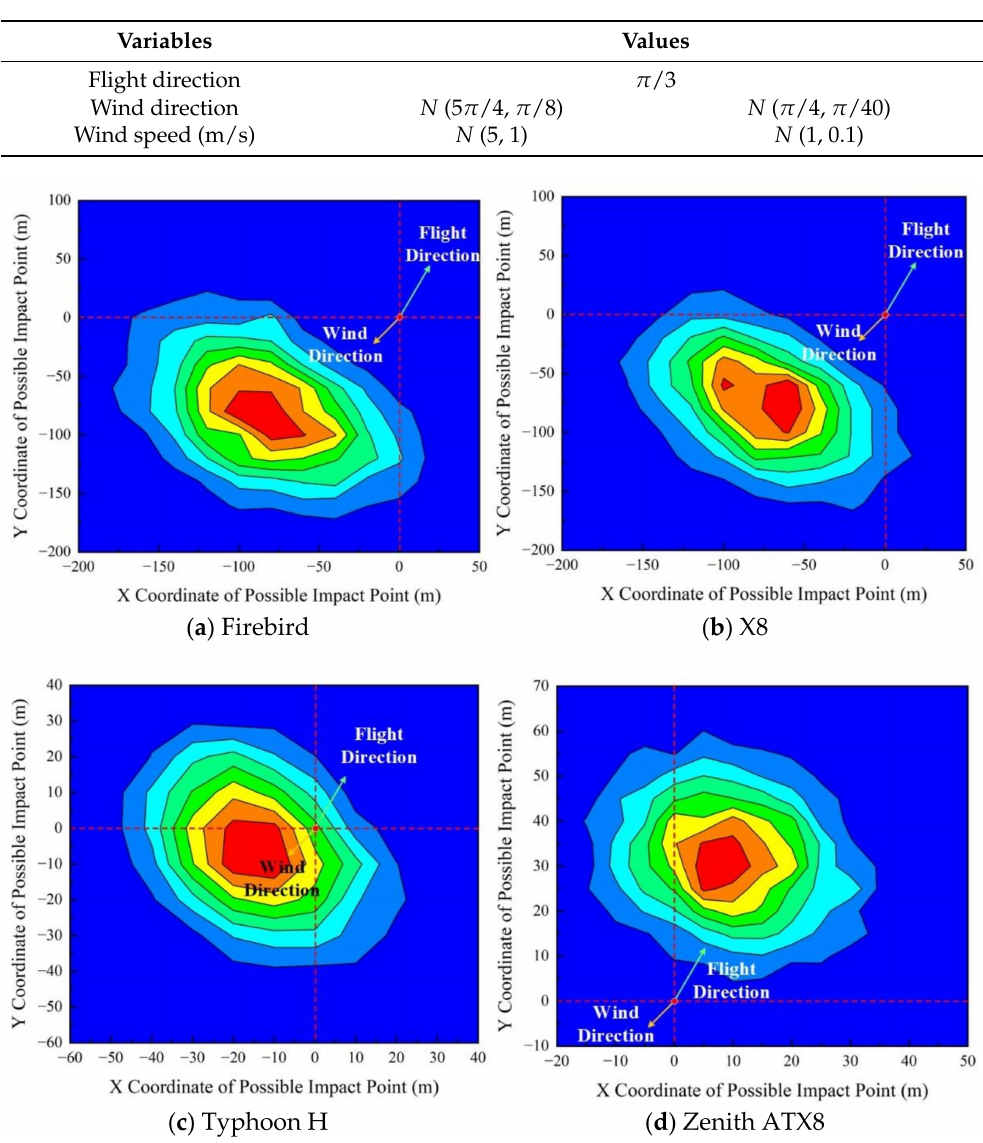
Table 6. Parameters for wind effects.